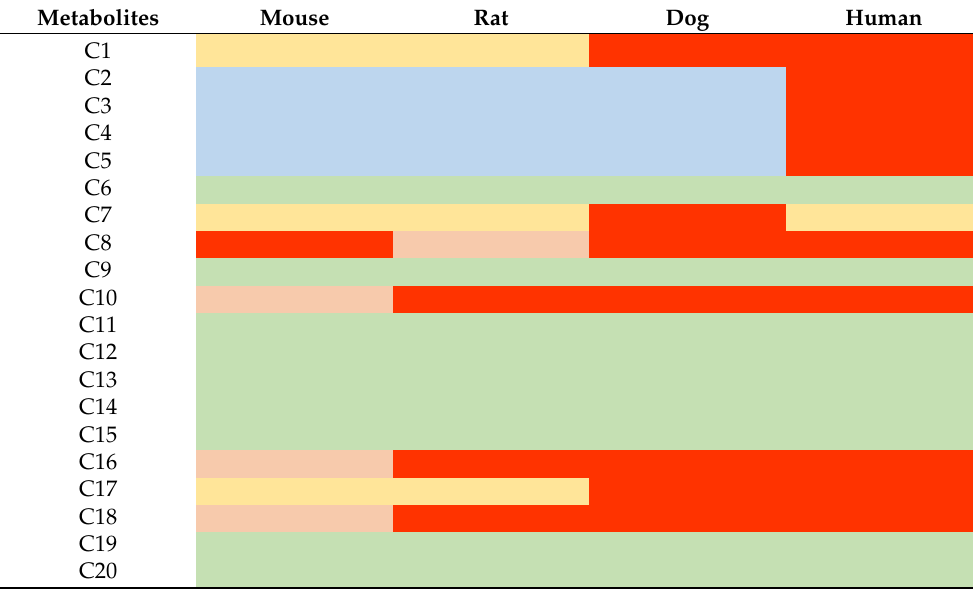
Table 2. Variations of metabolite production in different species. Metabolites Mouse Rat Dog